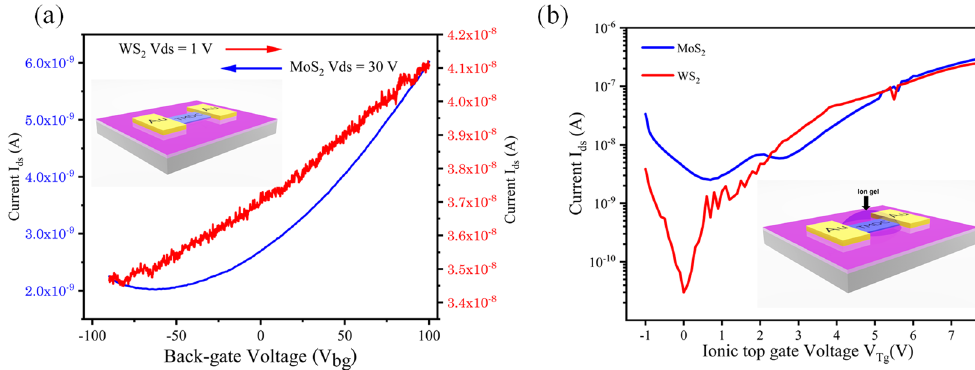
Figure 3. Transfer characteristics of laser-synthesised TMDCs-FET with ( a ) back-gated configuration and ( b ) Ionic top-gated configuration. Device schematics are also shown in inset